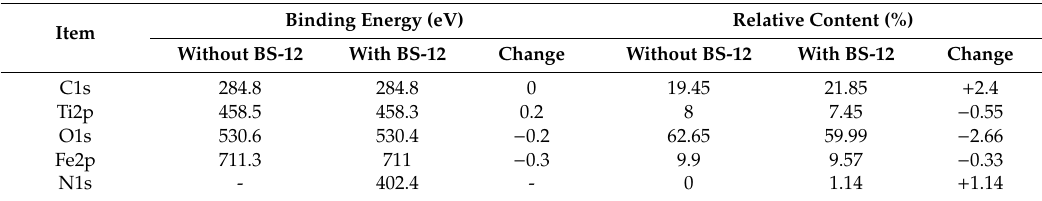
Table 2. Binding energies and relative content changes of different elements on the ilmenite surface, before and after BS-12 treatment.